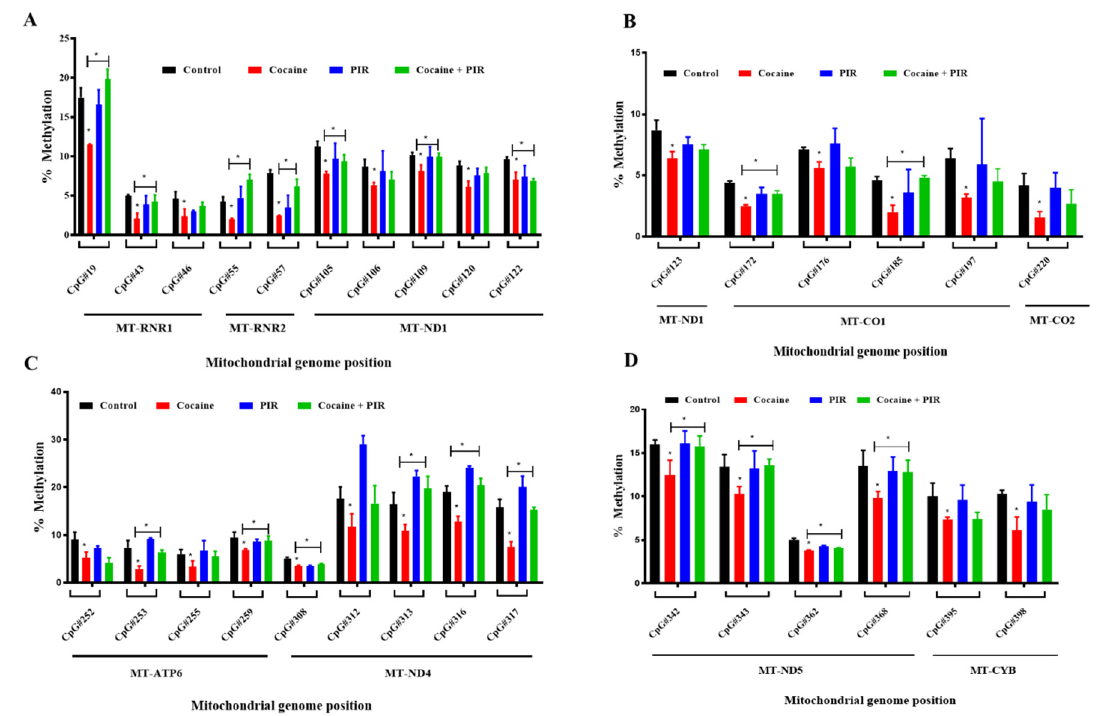
Figure 4. Analysis of mtDNA methylation by targeted next generation bisulfite sequencing (TNGBS). Human primary astrocytes were exposed to cocaine (1 µM) and/or piracetam (10 µM) for 24 h. The mtDNA methylation profiles were determined by TNGBS. Results represent the protective effect of piracetam on cocaine-induced hypomethylation in different mitochondrial CpG sites mt-RNR1, mt-RNR2, ND1, ND4, ND5, mt-CO1, mt-CO2, mt-ATP6 and mt-CYB ( A – D ). The results are expressed average of methylation percentage ± SD, * p < 0.05.